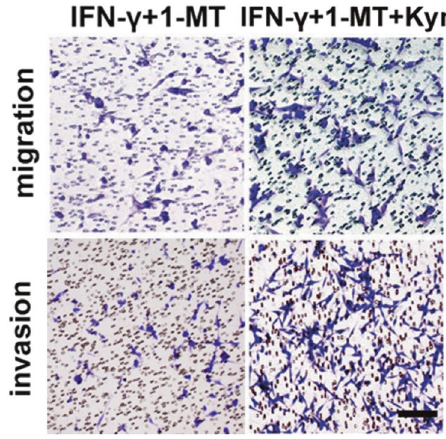
Fig. 4 h Migration and invasion assays of U87MG cells treated with IFN- γ + 1-MT or IFN- γ + 1-MT + Kyn. The authors mistakenly placed the wrong representative image showing the invasion ability of U87MG cells in the IFN- γ + 1-MT group. The correct version of Fig. 4h is shown